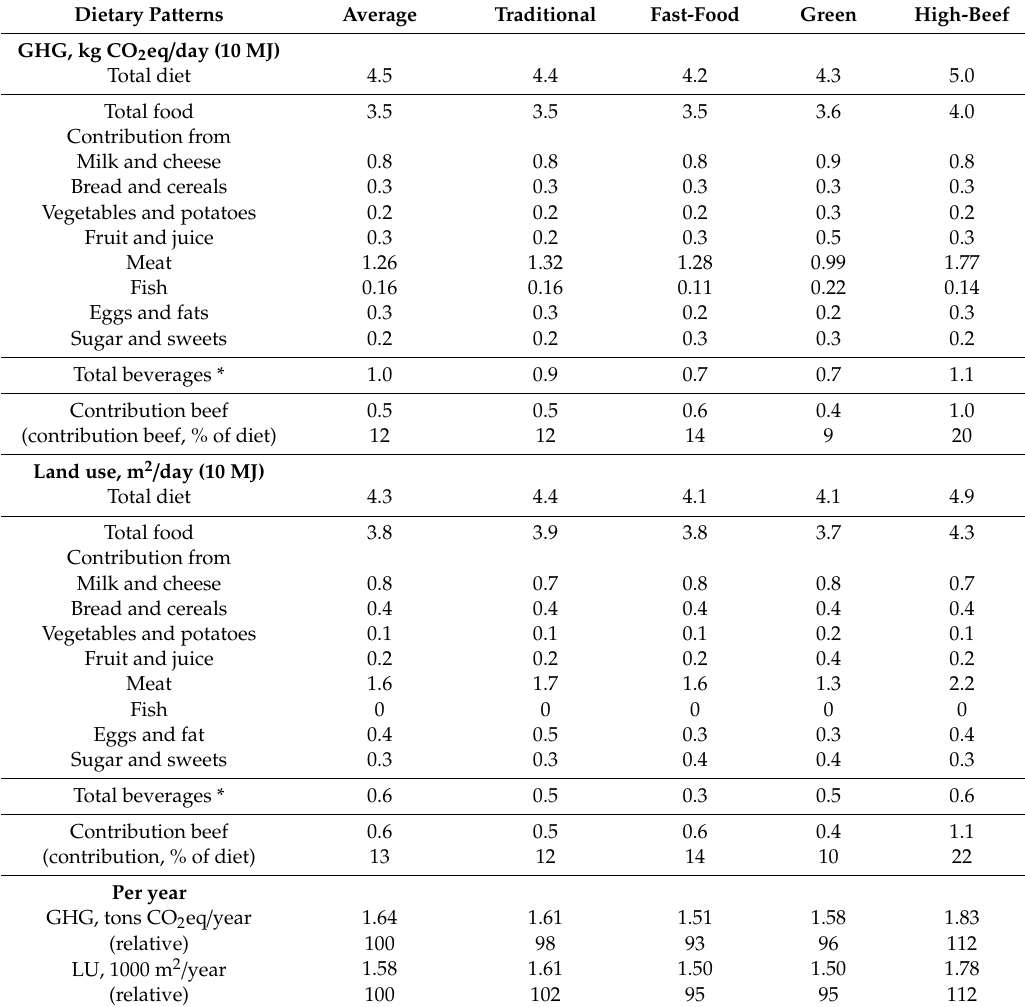
Table 5. Greenhouse gas emission (GHG) and arable land use (LU) of the di ff erent dietary patterns and the content of food and drinks, per person per day (10 MJ) (including the contribution from food waste). Dietary Patterns Average Traditional Fast-Food Green